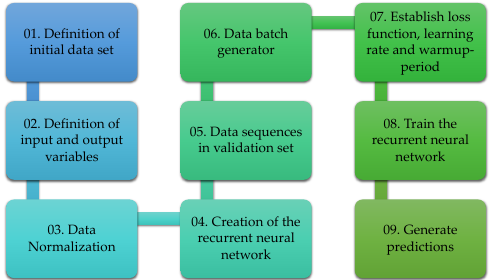
Figure 13. Steps for the development of the temperature prediction deep learning models.